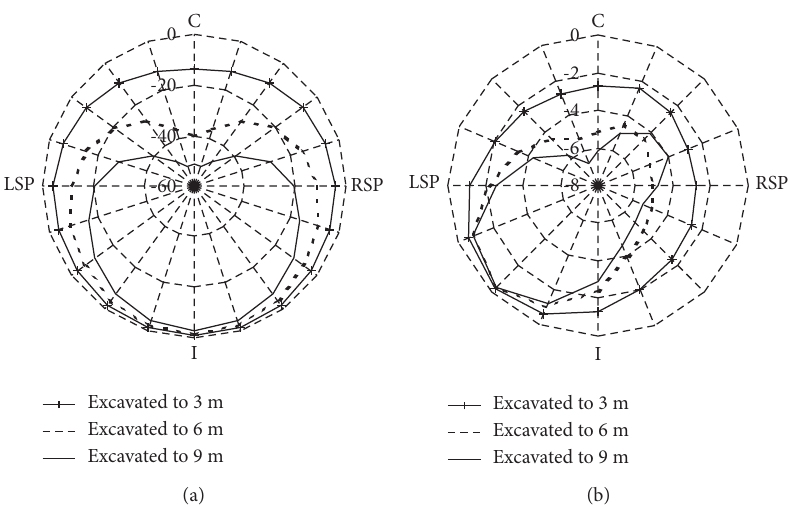
Figure 6: Normalized Earth pressure distributions ( Δ P / P